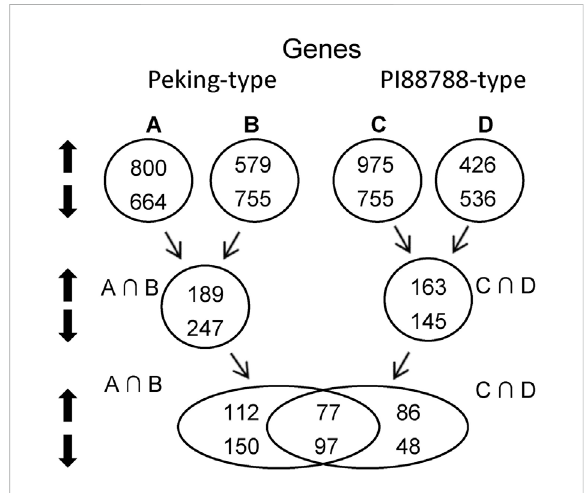
FIGURE 1 Strategy of pooled-sample analysis and the number of signi fi cant differentially expressed genes (DEGs) between Peking- and PI 88788-type sources of resistance. A, Peking versus (vs.) Hutcheson; B, Pool-a vs. Pool-c: the pool of PI 90763, PI 404166, PI 89772, PI 437654, and PI 438489B vs. the pool of Williams82andMagellan;C,PI88788vs.Hutcheson;D,Pool-bvs. Pool-c: the pool of PI 437655, PI 495017C, PI 209332, PI 438503A and PI 467312 vs. the pool of Williams 82 and Magellan; A ∩ B, intersection between (A) and (B) ; C ∩ D, intersection between (C) and (D)